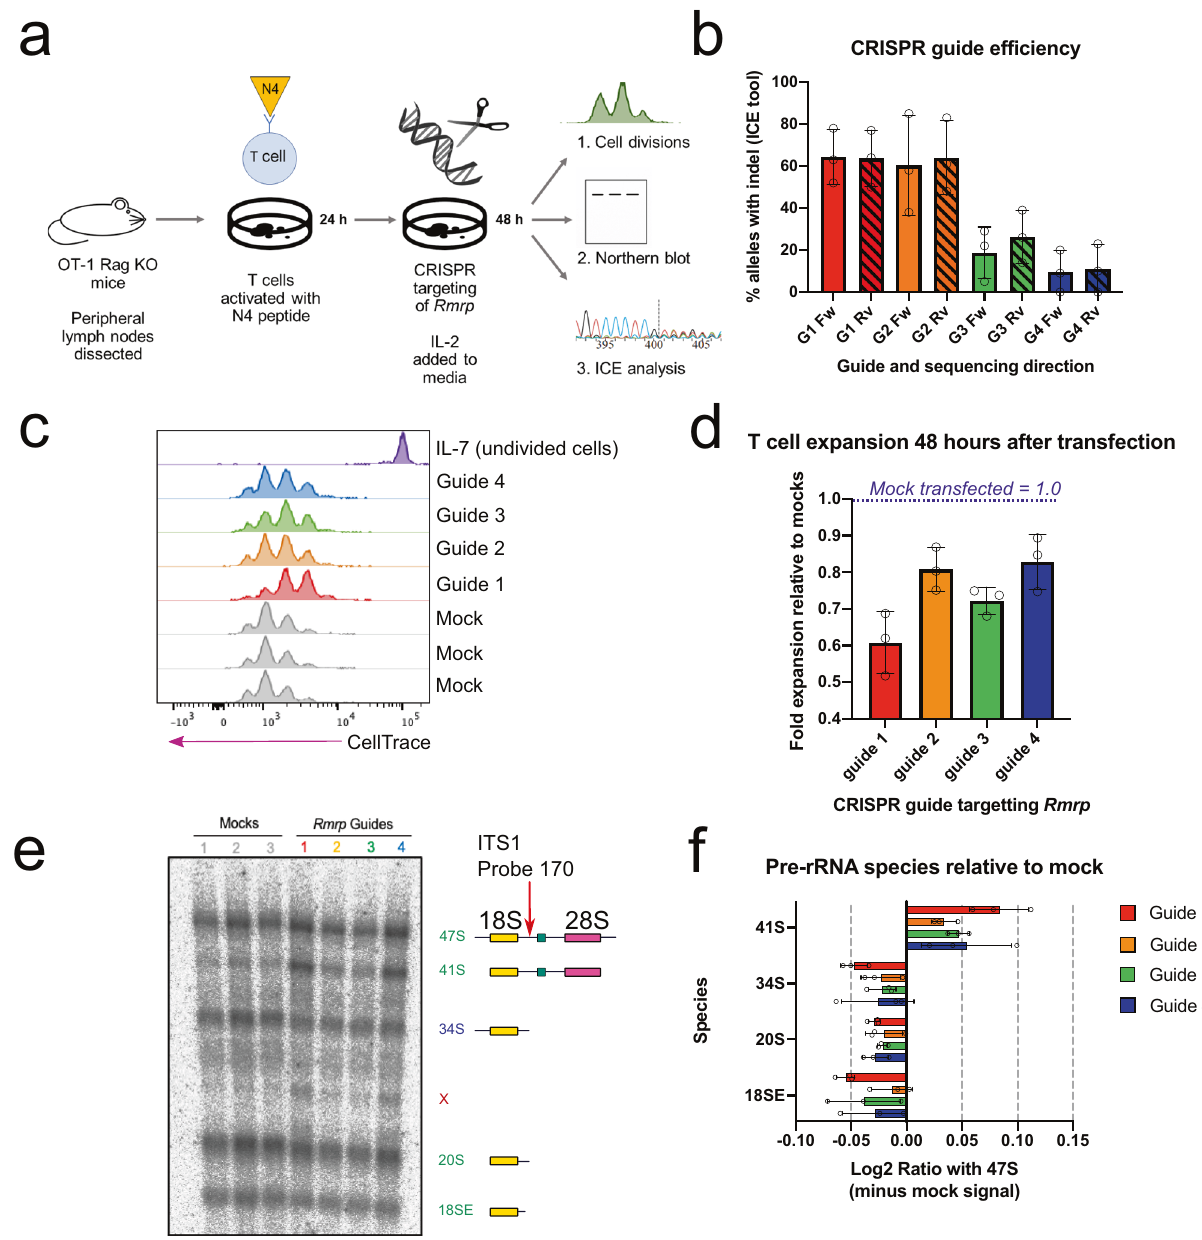
Fig. 1 Disruption of RMRP impairs T cell proliferation and rRNA processing. a Outline of experiment. Naïve TCR transgenic (OT-1) T cells were obtained from mouse peripheral lymph nodes and activated with N4 peptide. After 24 h, cells were electroporated with a CRISPR mix targeting Rmrp , or a mix without the guide (mock-transfected controls). After 48 h, cells were analyzed by fl ow cytometry for proliferation, northern blotting for pre-rRNA species, and ICE analysis to determine CRISPR guide ef fi ciency. b CRISPR guide ef fi ciency as determined by the Synthego Inference of CRISPR Edits (ICE) tool.